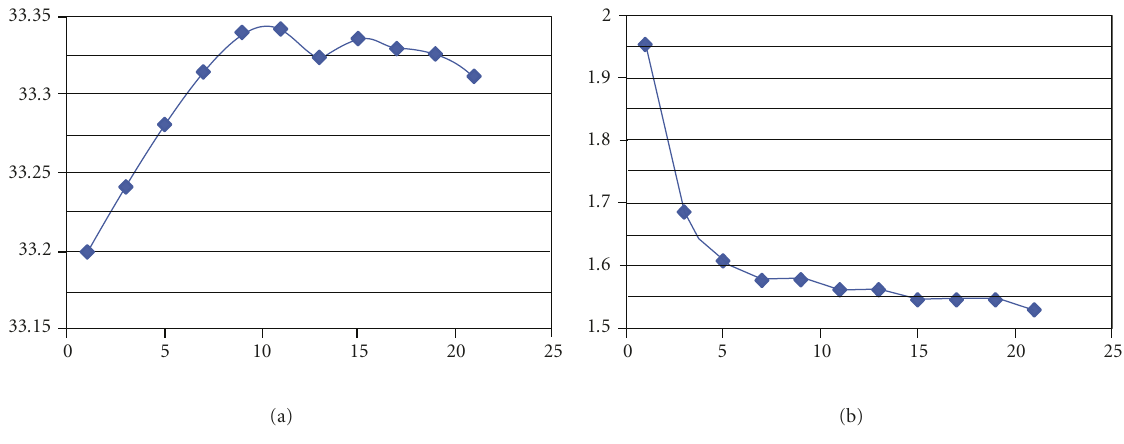
Figure 7: Performance of the proposed algorithm at di ff erent settings of threshold T flat : (a) PSNR and (b) Run Time.